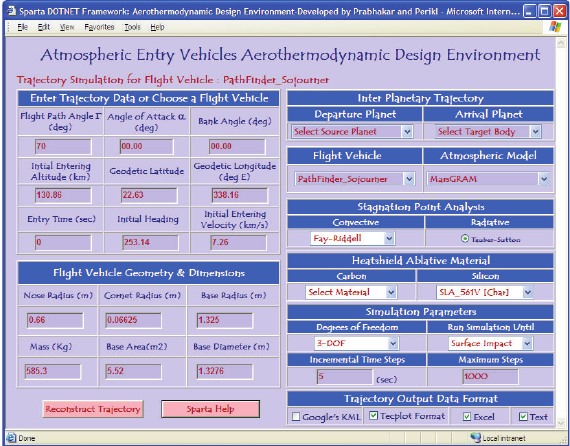
Figure 12: Sparta framework flight vehicle user interface.